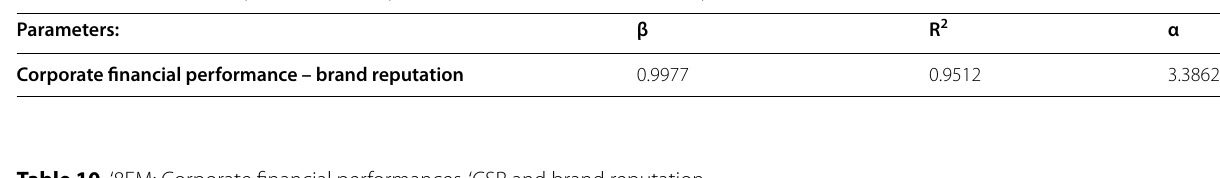
Table 10 ‘8EM: Corporate financial performances, ‘CSR and brand reputation Parameters: